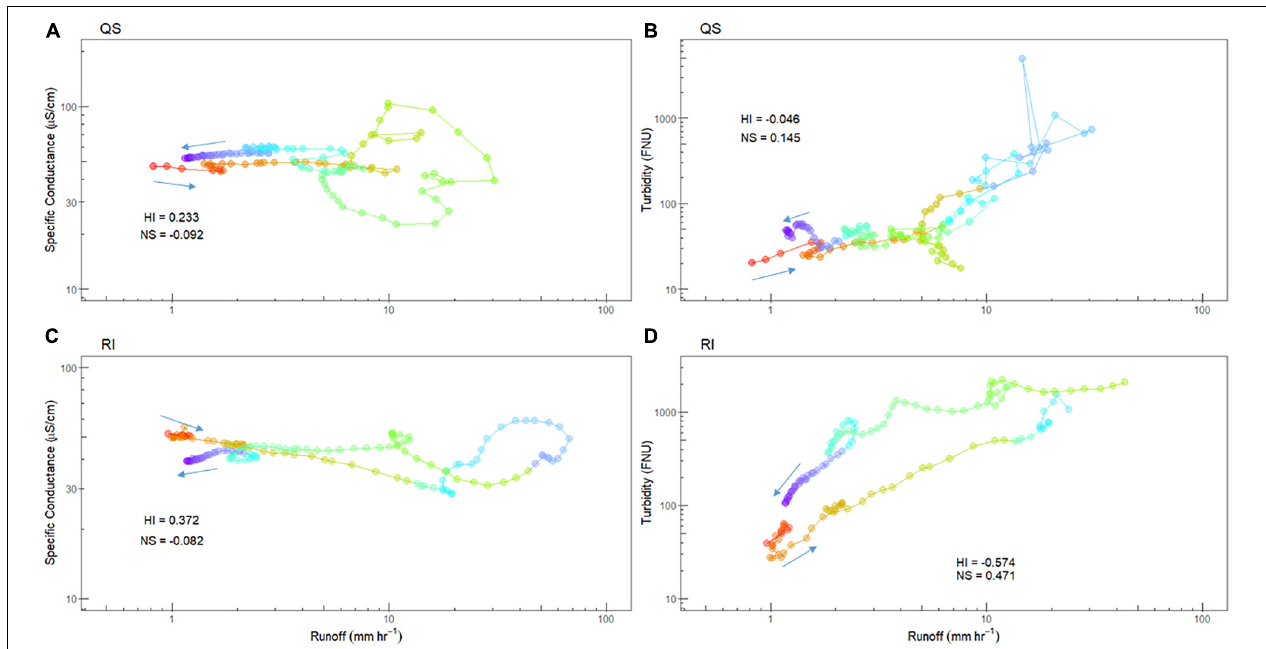
FIGURE 4 | The response of specific conductance and turbidity to Hurricane Maria in Quebrada Sonadora (QS: A,B ) and Rio Icacos (RI: C,D ). Red/orange colors represent the beginning of the storm and blue/purple colors represent the end of the storm. Arrows also provide beginning and ending points of each event. HI and normalized slope (NS) values are presented for each storm. Note that both axes are